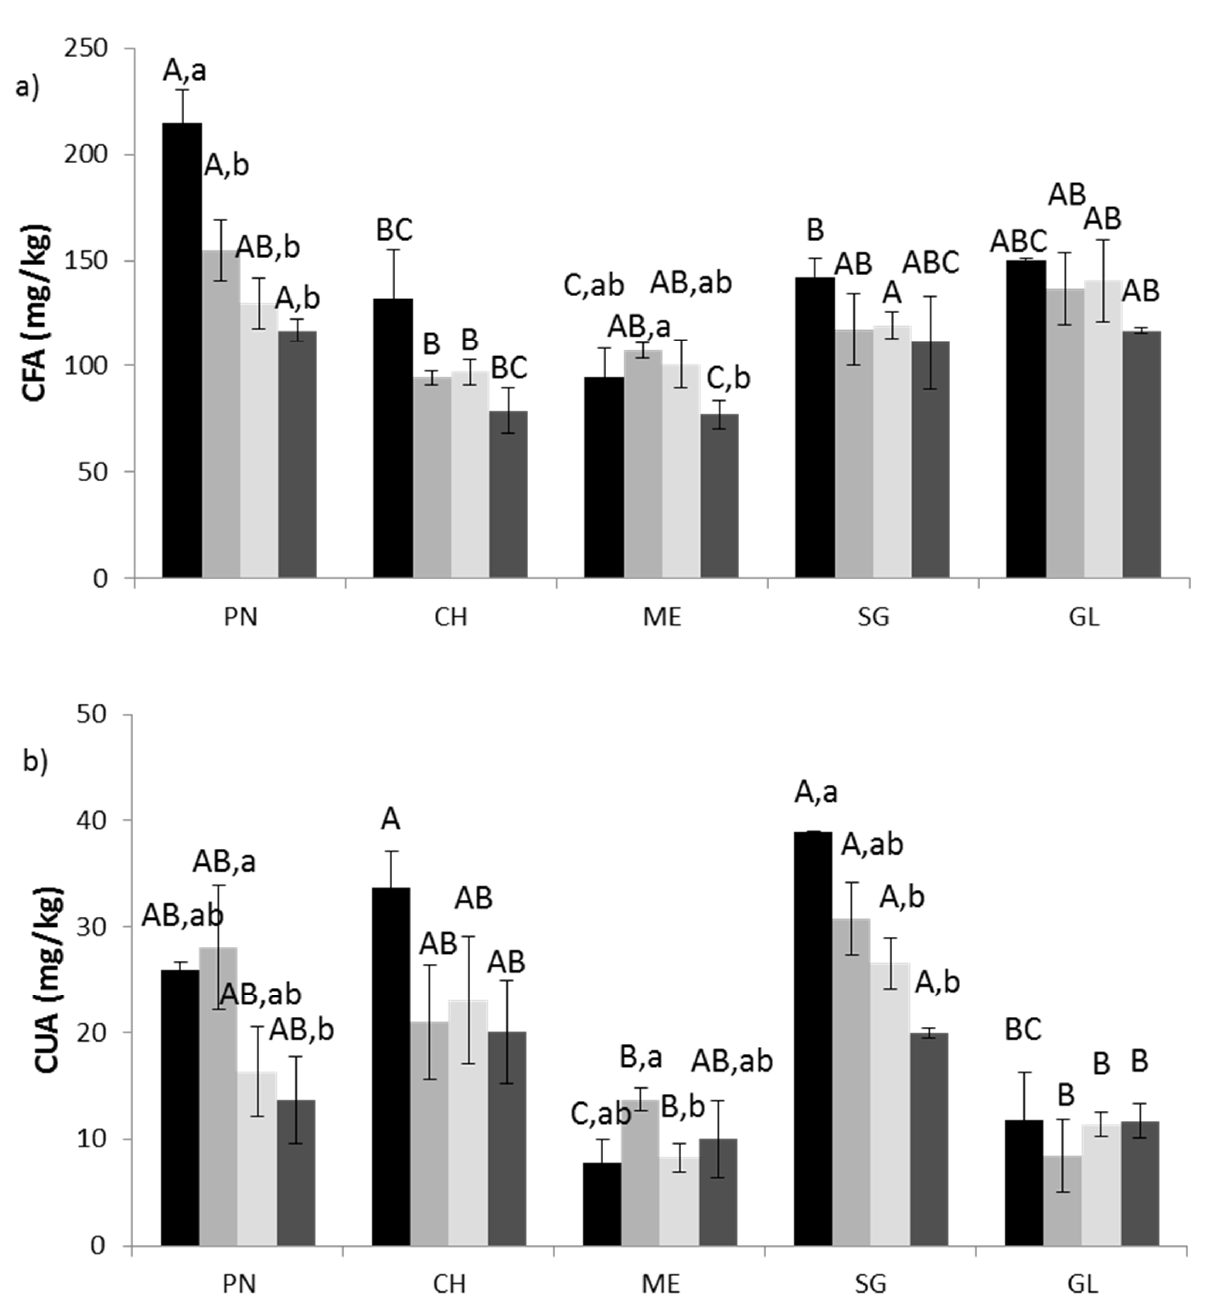
Figure 2. Standardized caftaric acid ( a ) and coutaric acid ( b ) content of verjuice. PN: Pinot noir, ME: Merlot, CH: Chardonnay, SG: Sangiovese, GL: Glera. Black bars: week one of sampling, grey bars: week two of sampling, light grey bars: week three of sampling, dark grey bars: week four of sampling. Different capital letter indicates significant differences among varieties at the same week of sampling; different lowercase letters indicates significant differences among weeks within the same variety.